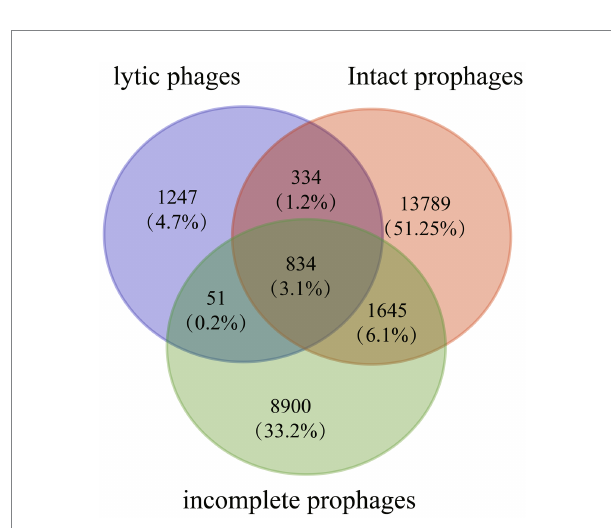
FIGURE 6 Venn diagrams showing the number of orthologous groups among 579 intact prophage sequences, 1,389 incomplete prophages, and 188 lytic